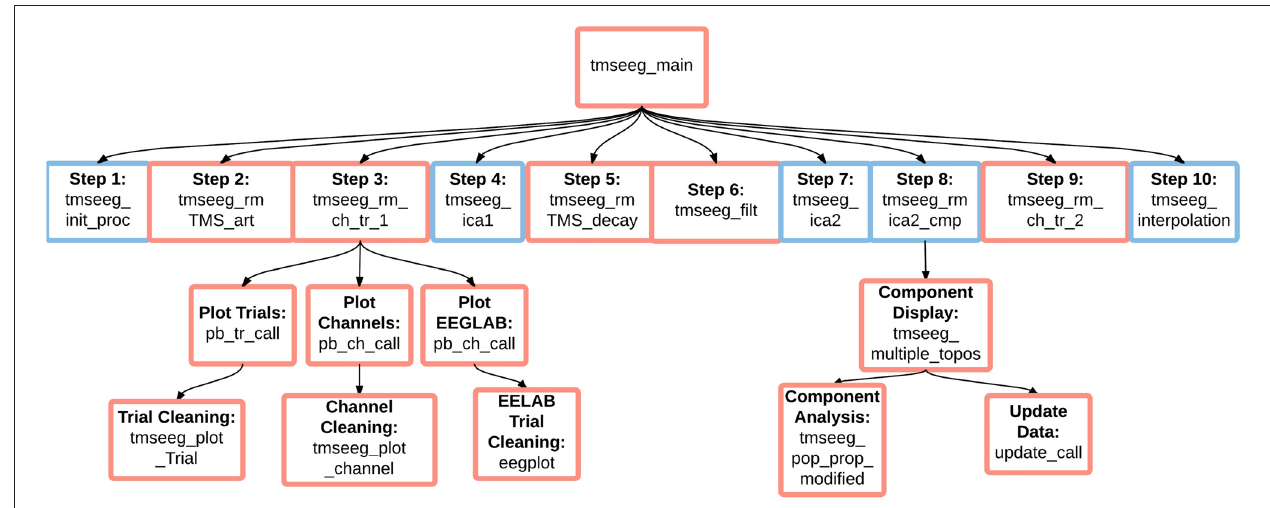
FIGURE 8 | TMSEEG software architecture. An illustration of the basic dependencies and relationships between TMSEEG functions. Arrows indicate that a higher level function calls on a lower level “child” function. Blue boxes indicate a functional step, while red boxes indicate that the step spawns a child GUI.